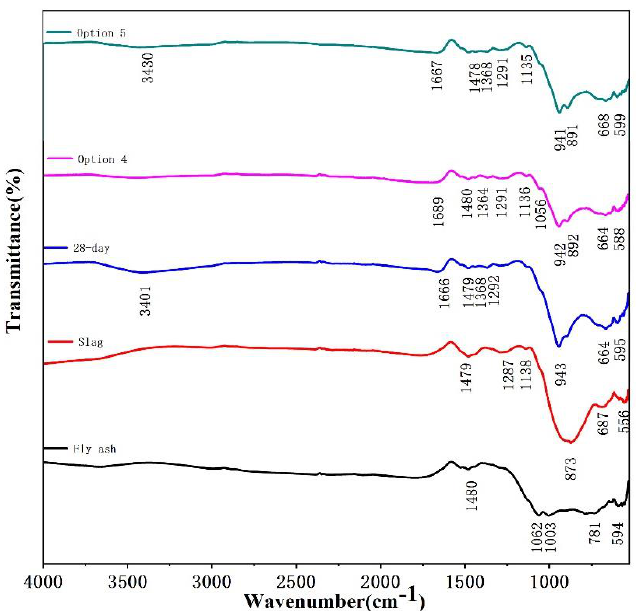
Figure 12. Infrared spectrum of slag, fly ash, and differential mix proportion test specimens.